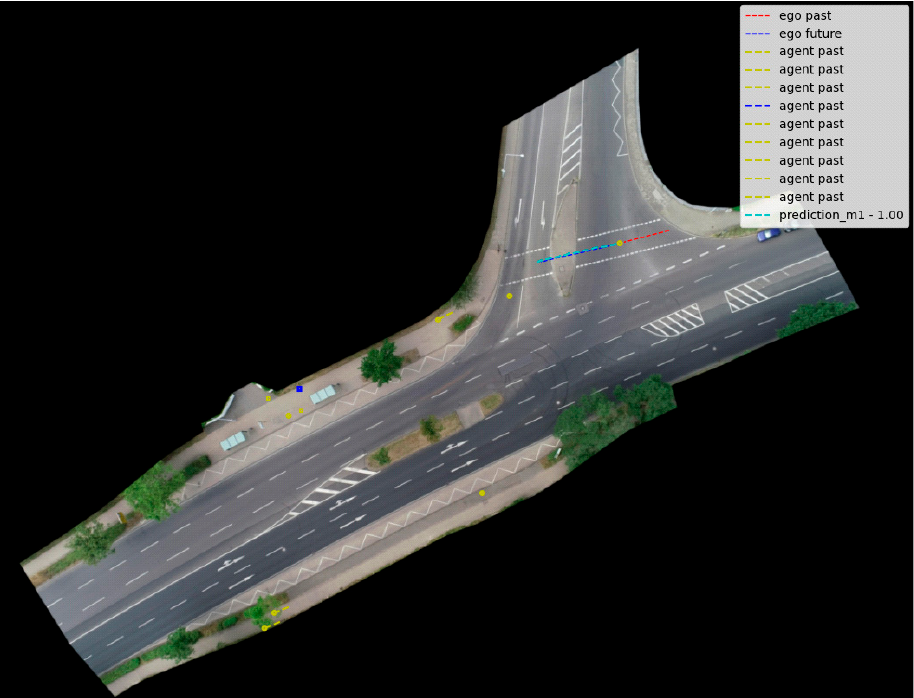
Figure 15. Traffic scene prediction with the unimodal approach. In this scenario, the pedestrian is crossing the street on the sidewalk.